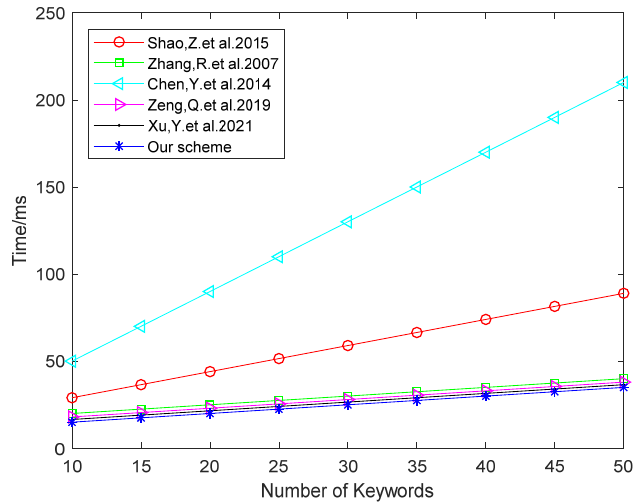
Figure 3. Time of encryption algorithm [5–7,15,29].